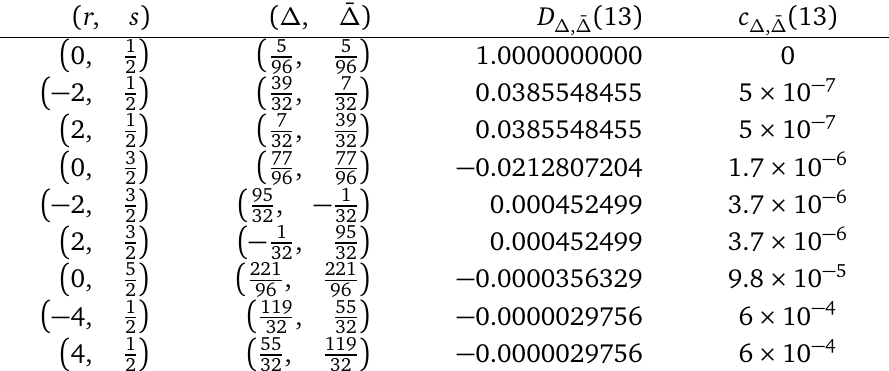
to N = 13 states at c = 0, while showing the results 2 (cid:90) , (cid:90) + 1 2